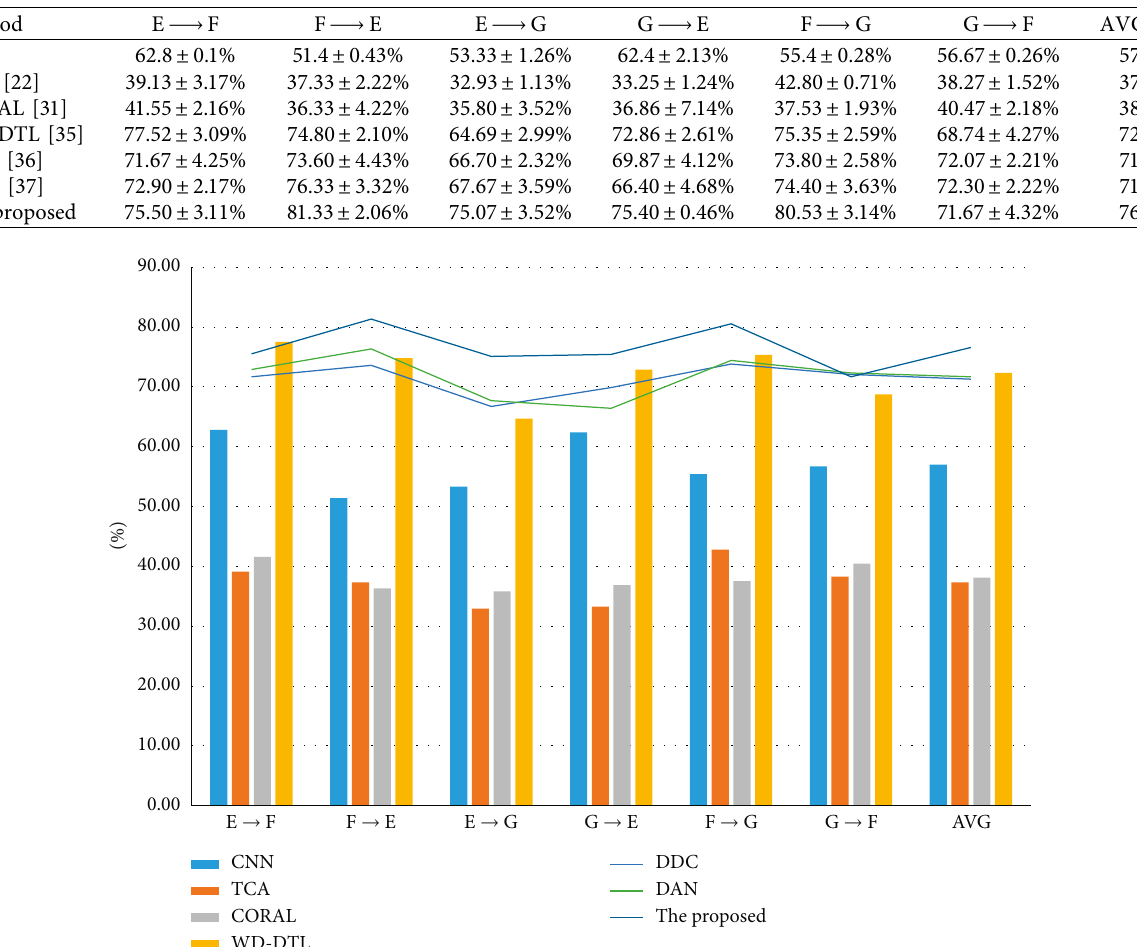
Figure 9: Classification accuracy of mentioned